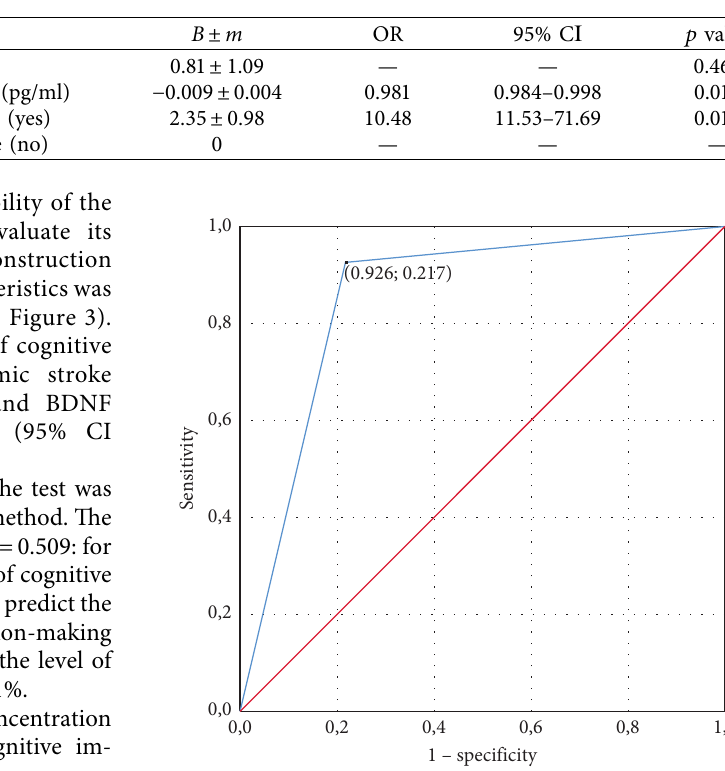
Figure 3: ROC curve for prognostic model of cognitive impair- ments in acute period of ischemic stroke based on BDNF level on the 1st day and hemodynamic